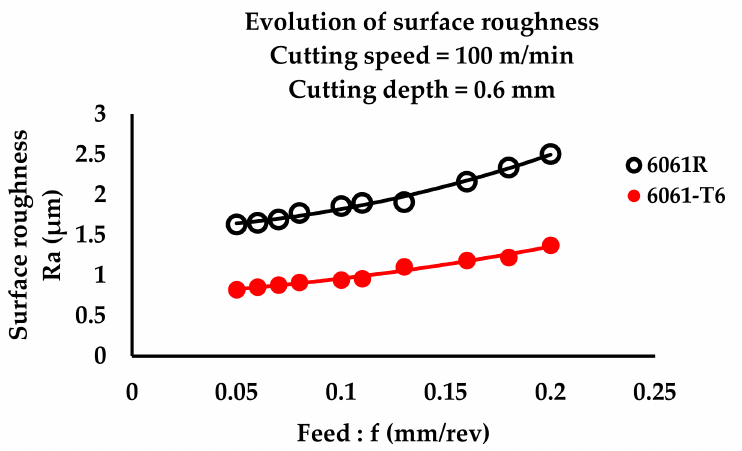
Figure 7. Evolution of the surface roughness as a function of the feed during machining with lubrication of recycled alloys 6061 R and